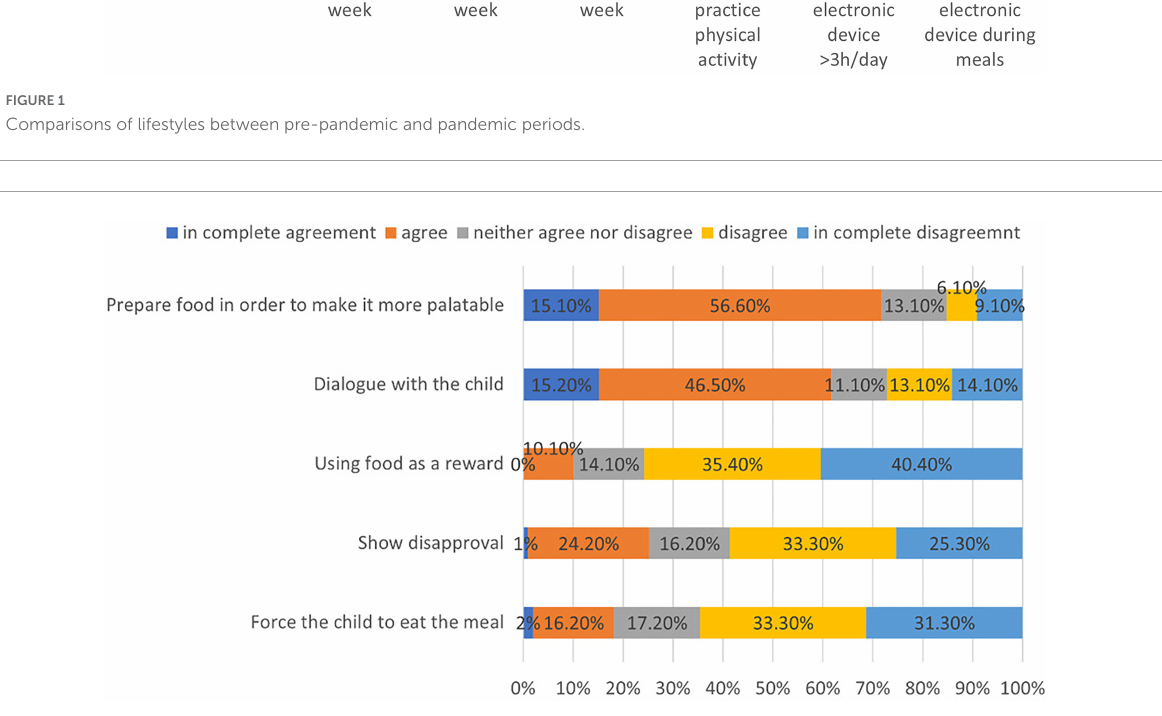
FIGURE1 Comparisons of lifestyles between pre-pandemic and pandemic periods.